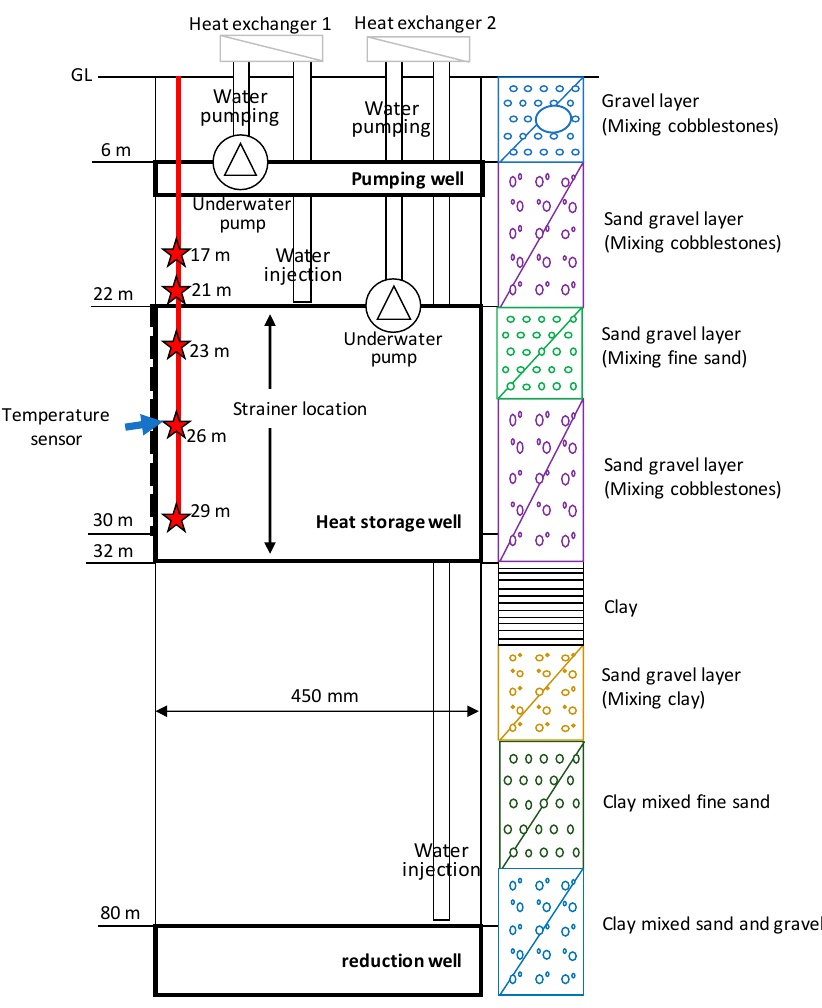
Figure 3. The stratum diagram of the heat storage well.